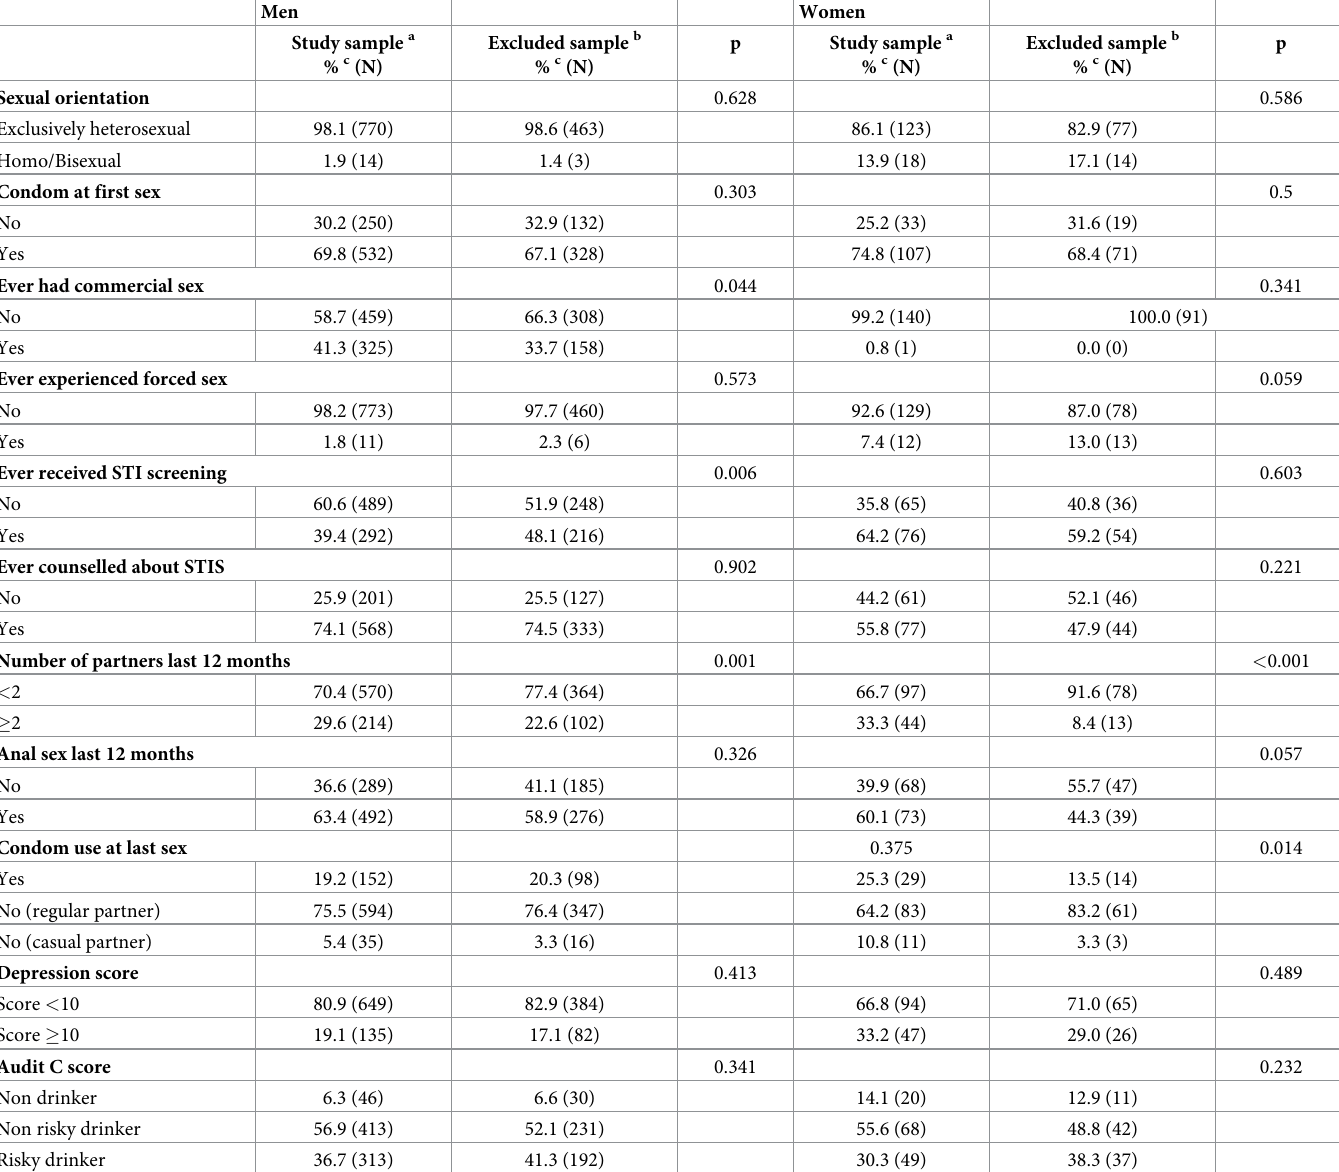
Table 2. Sexual lifestyle and mental health indicators characteristics of the study sample (n = 925) and of respondents excluded from the analysis (n = 557), COSE- MIL survey. Men Women Study sample